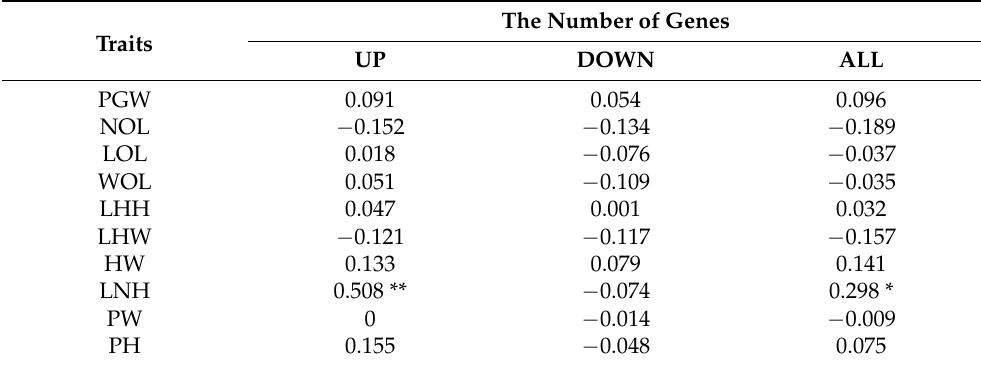
Table 3. The correlation between the number of parental differential expression genes and the mid-parent heterosis value of traits in hybrids. The Number of Genes Traits UP DOWN ALL PGW 0.091 0.054 NOL − 0.152 − 0.134 − 0.189 LOL 0.018 − 0.076 − 0.037 WOL 0.051 − 0.109